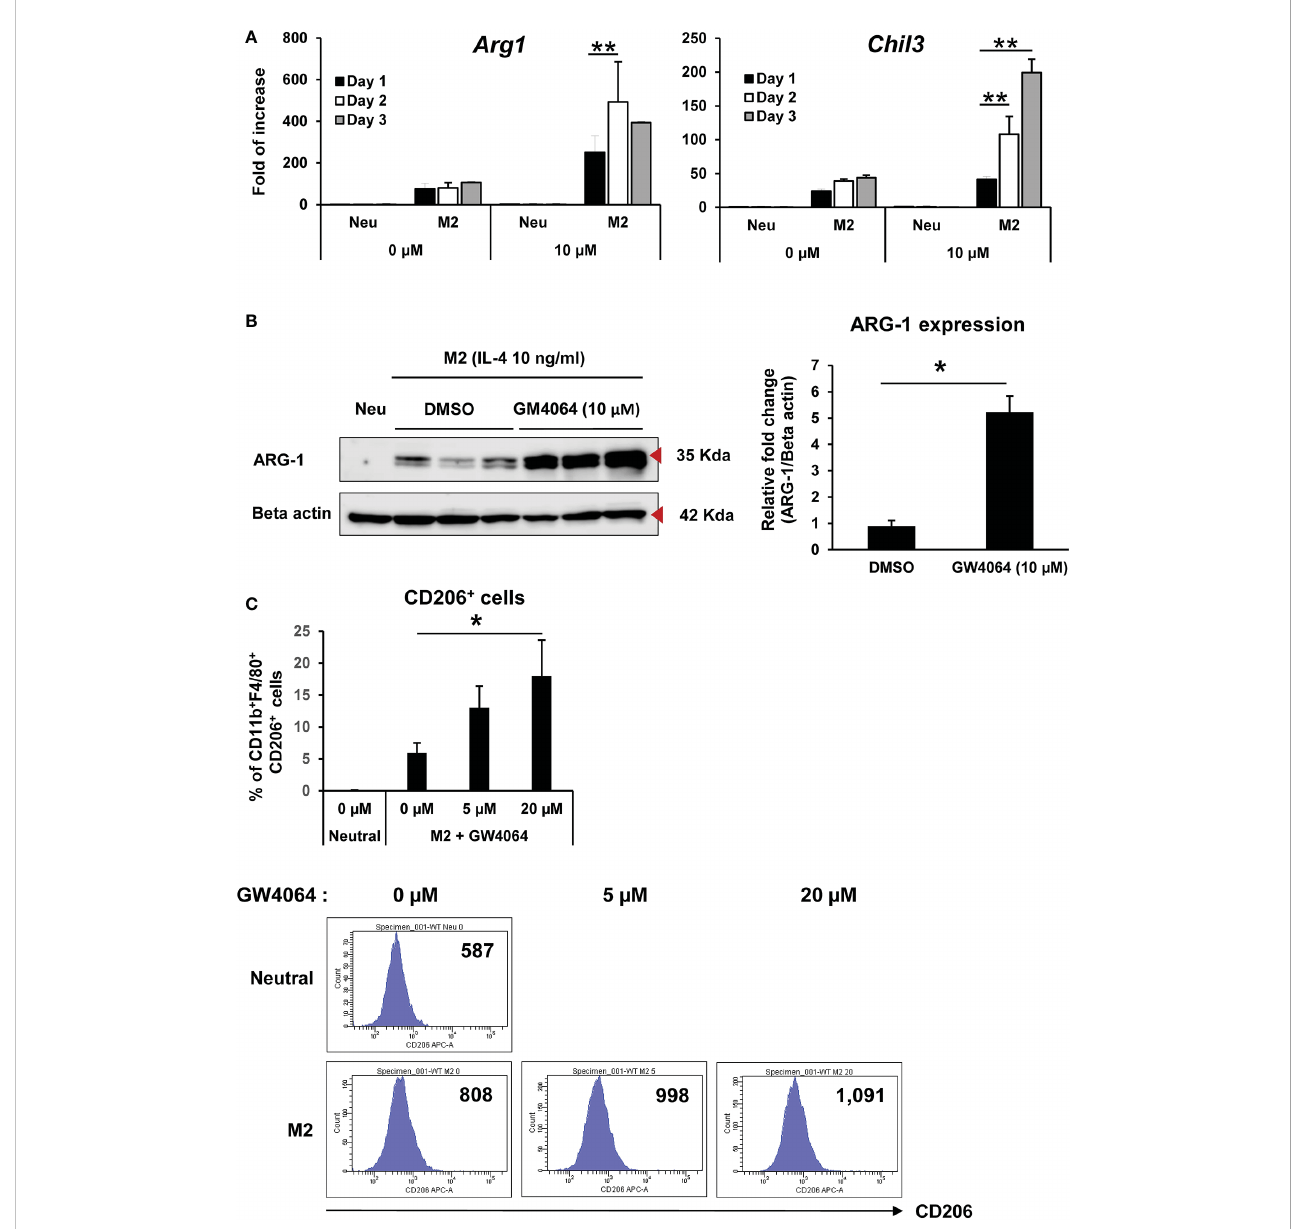
FIGURE 2 Activation of FXR with GW4064 increased expression of M2-associated markers. (A) BMDMs were treated with or without 10 µM of GW4064 under the M2 condition from 1 to 3 d, and left untreated as a Neu condition and M2-associated gene expression then measured by real-time PCR. (B) ARG-1 protein (35 kDa) expression was examined by immunoblotting on day 2 of GW4064 treatment under M2 conditions, with relative ARG-1 expression normalized to b -actin (42 kDa) expression (left panel). The graph shows the relative expression of ARG-1 protein in GW4064-treated cells compared to that of the vehicle control group (right panel). (C) BMDMs were treated with 0, 5, or 20 µM of GW4064 under the M2 condition for 3 d. Flow cytometry analysis of CD11b + F4/80 + CD206 + and CD206 expression on the cell surface was performed, with the results expressed as the percentage of CD206 in CD11b + F4/80 + cells (upper panel) and MFI (lower panel). Each experiment was carried out in triplicate and repeated three times. The results of the representative data are shown as mean +/- SD. Analysis of variance (ANOVA) and the Student ’ s t test were used for the statistical analyses. MFI: mean fl uorescence intensity. * P < 0.05, ** P <